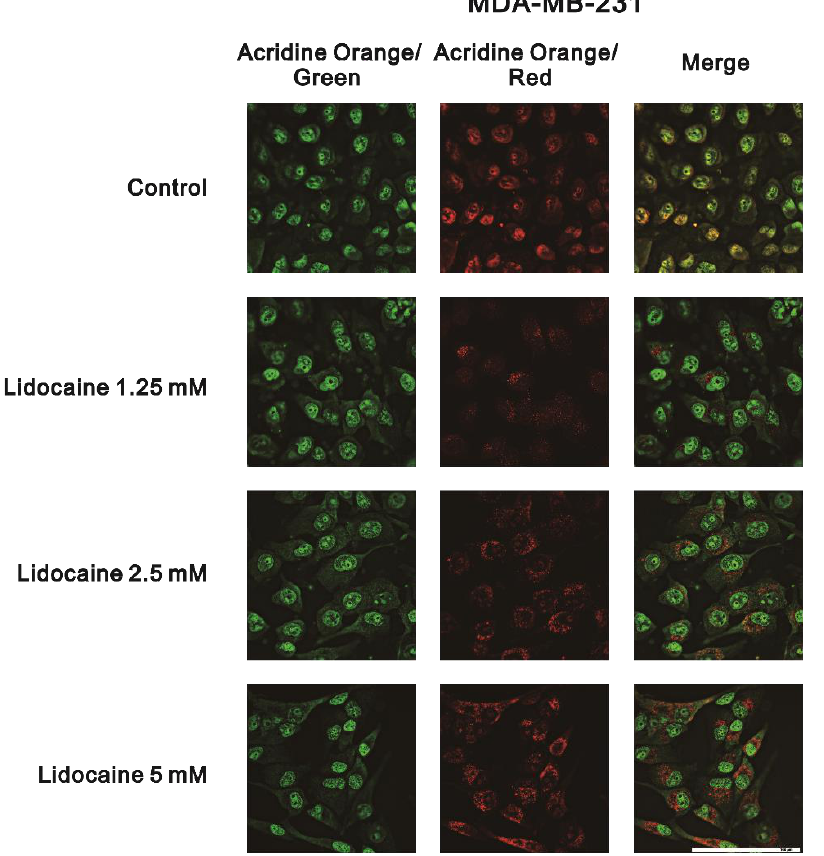
Figure 10. The detection of lidocaine-induced acidic vesicular organelles using acridine orange staining. MDA-MB-231 (3 × 10 5 ) cells were treated with the indicated concentration of lidocaine for 48 h before being stained with 1 µg/mL of acridine orange. The formation of acidic vesicular organelles was examined via fluorescence microscopy. Acridine orange is a weak base that accumulates in acidic spaces and results in bright red fluorescence (punctuation) in the cytoplasm, which can be detected by fluorescence microscopy. Scale bar = 100 µm.